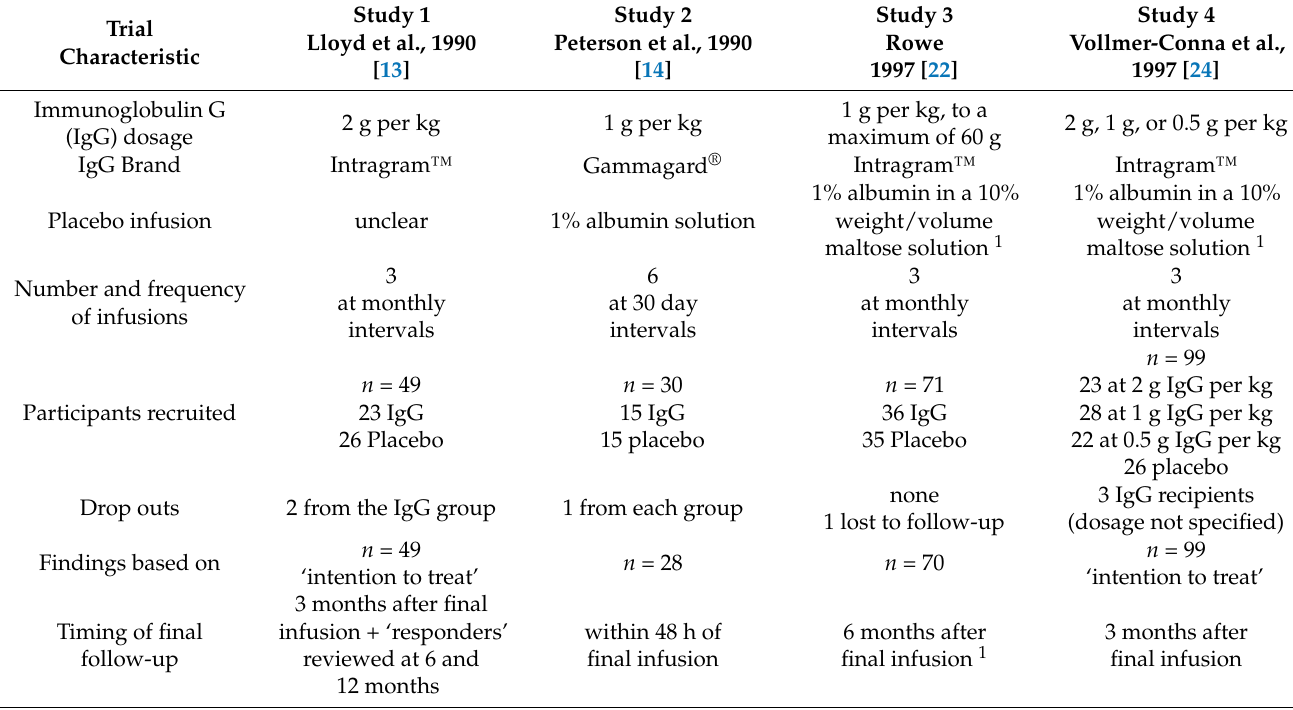
Table 1. IV immunoglobulin trial characteristics.